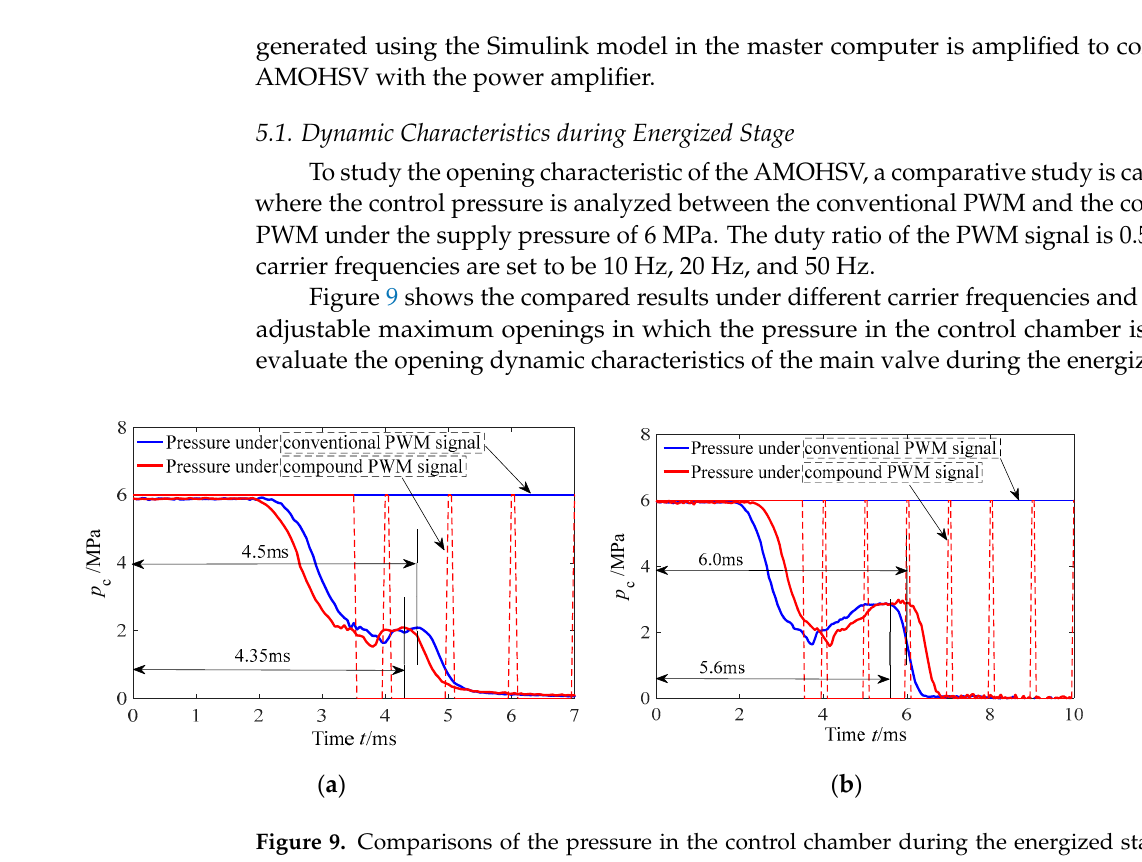
Figure 8. A prototype of the proposed AMOHSV.